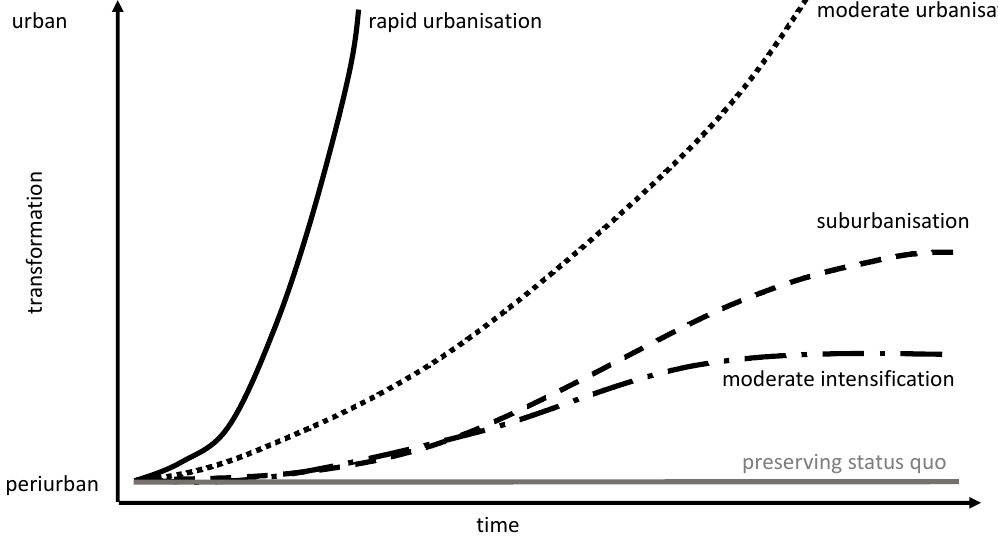
Figure 4. Development trajectories of urban fringe